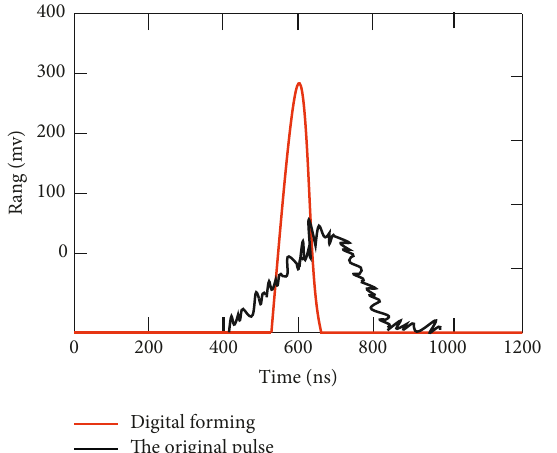
Figure 6: Signal simulation and digital S – K forming results of continuous nuclear engineering cost data.